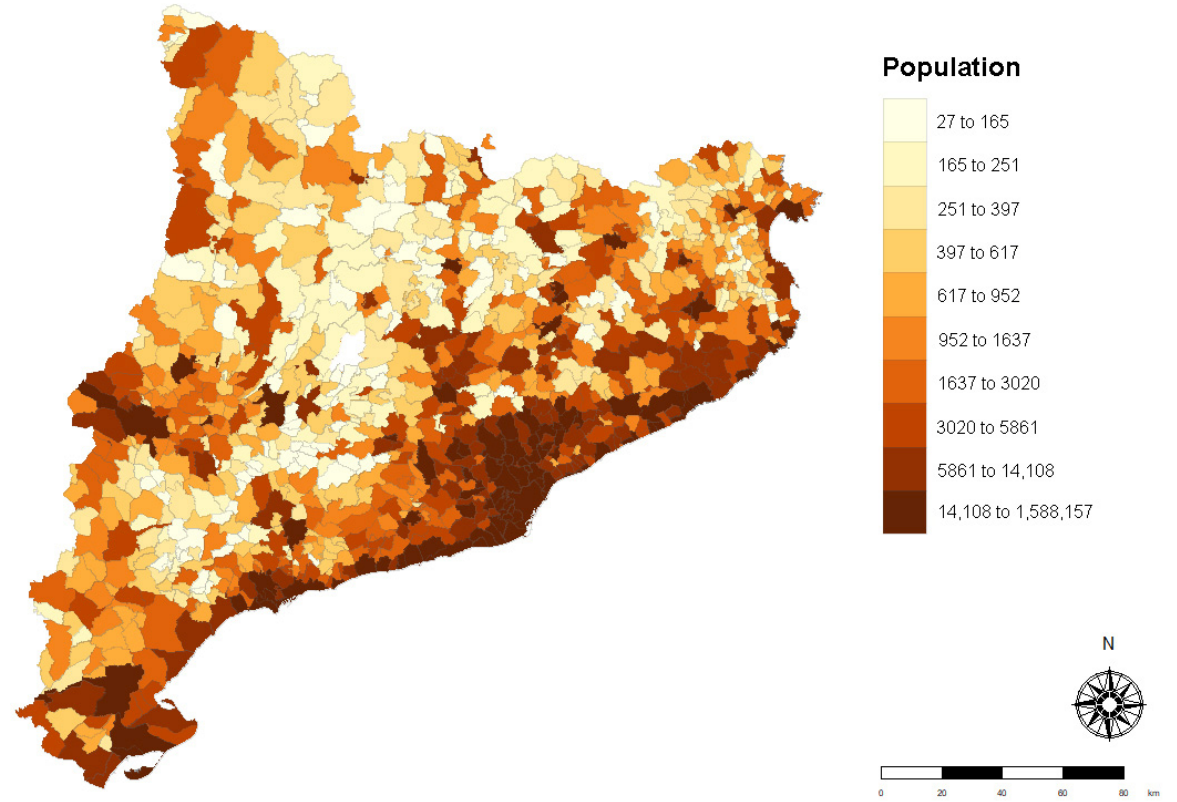
Figure 1. Map of the population of Catalonia by municipalities.